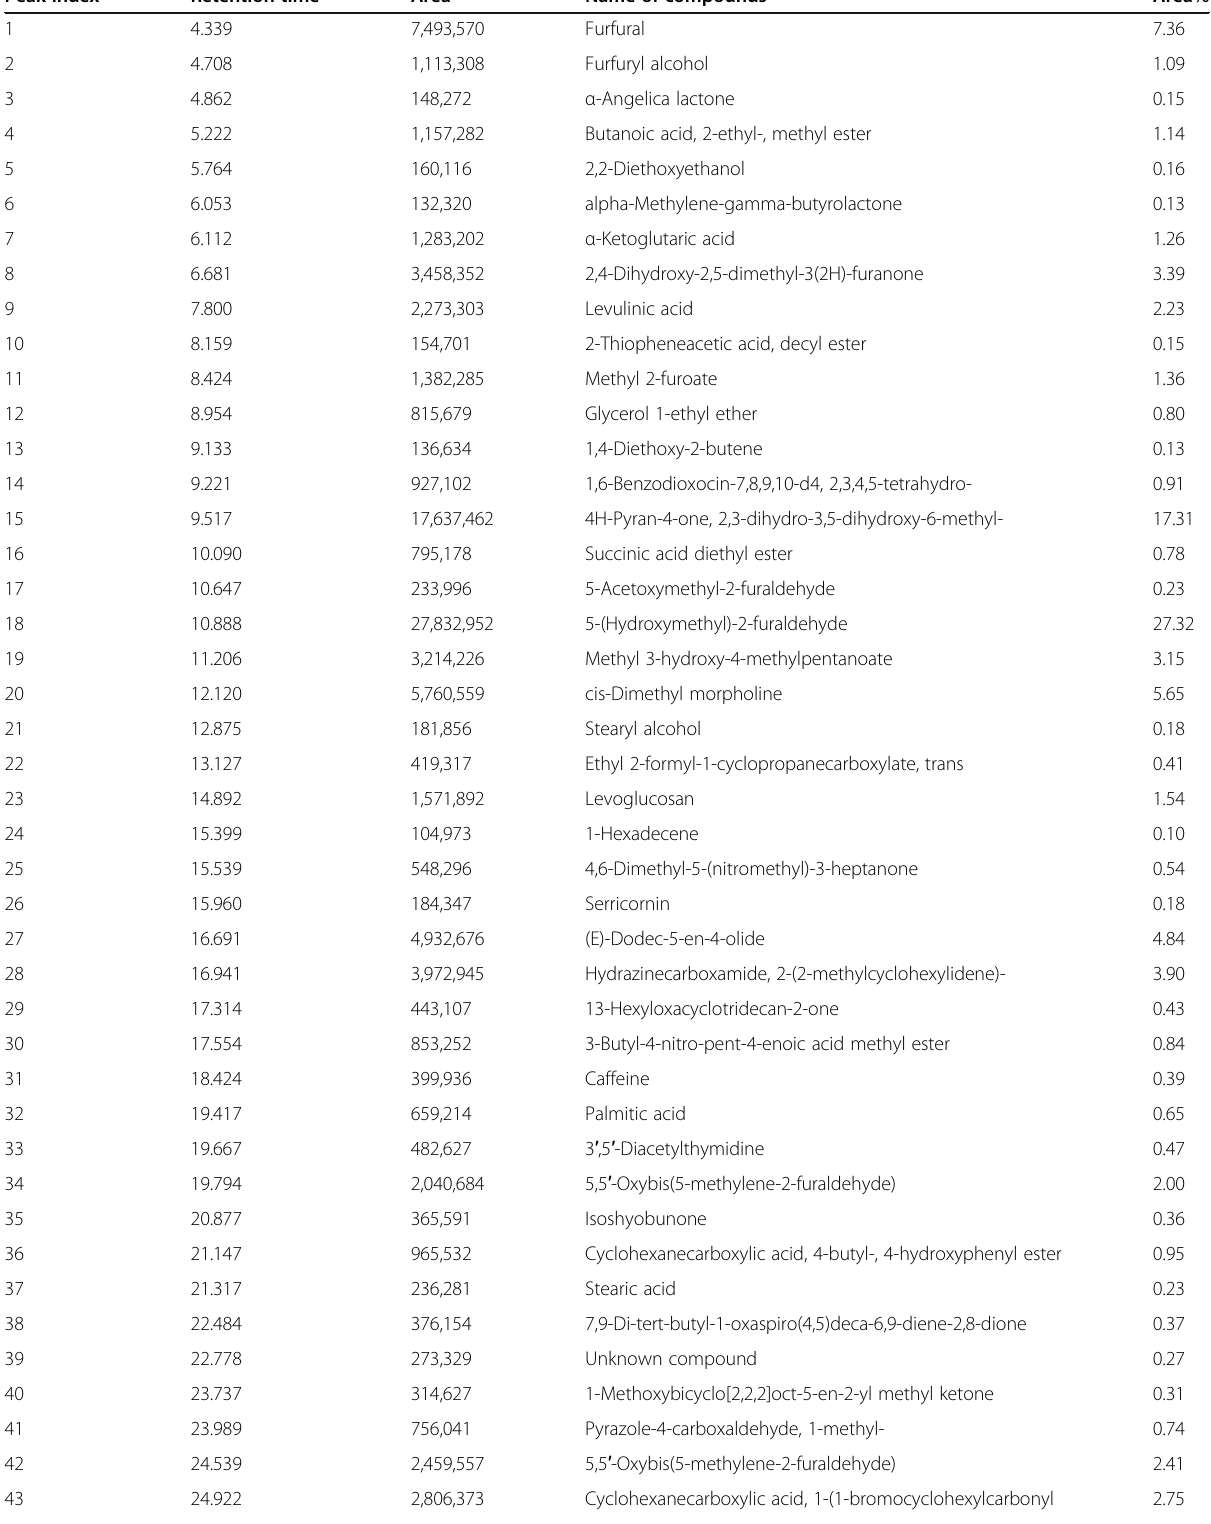
Table 1 GC-MS peak report for the sample fermented tea petal decoction (FTPD) with names of compounds as detected Peak